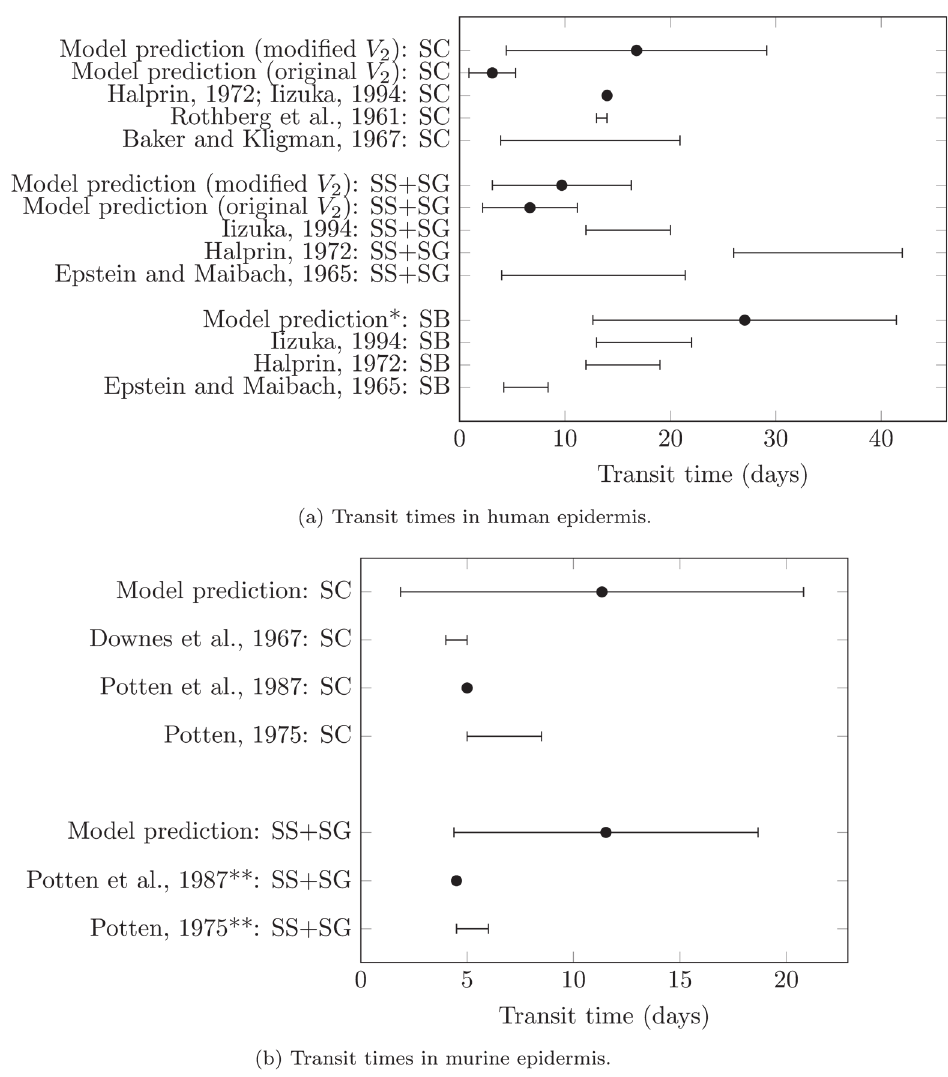
Figure 3. Comparison of epidermal sublayer transit times predicted by our model with experimental literature values. (a) Human literature values from [87 – 91]. (b) Murine literature values from [92 – 94]. * Model prediction in the SB was independent of the value of V 2 . ** Value may include some residence time in the